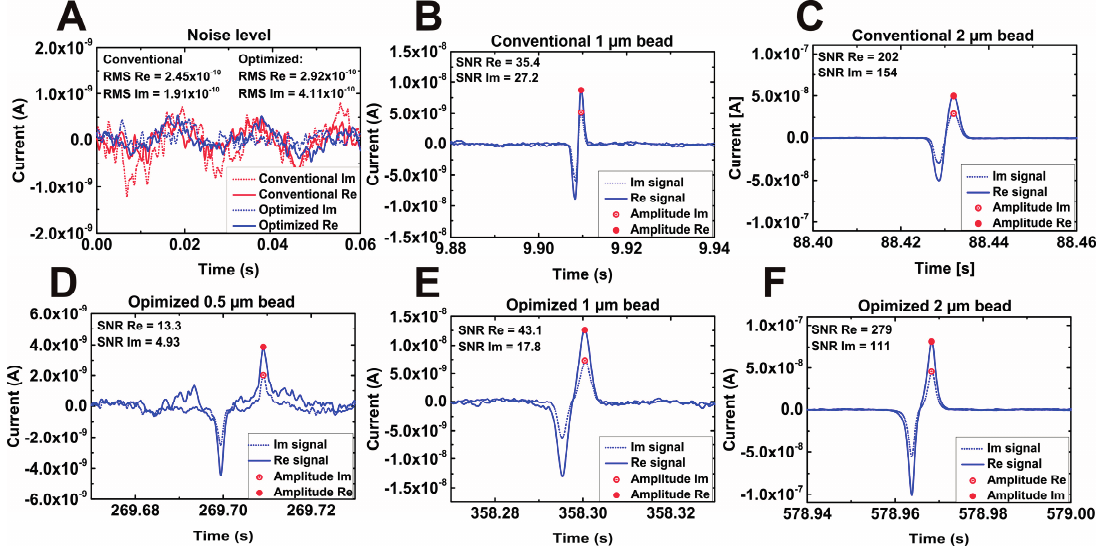
Figure 5. Signal plots in time of the transitions of the different particles in the conventional and optimized chip design. ( A ) Plot of the noise level of the different